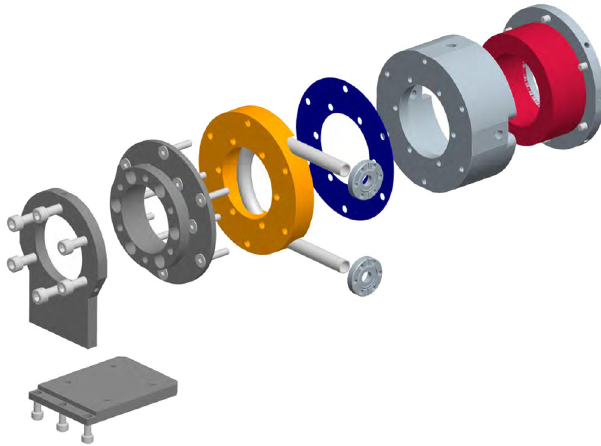
FIG. 7. Exploded drawing of the solenoid [17], from left to right: Support, main bracket, copper cooling block (orange), indium disc, iron yoke, SC coil (red), and yoke back